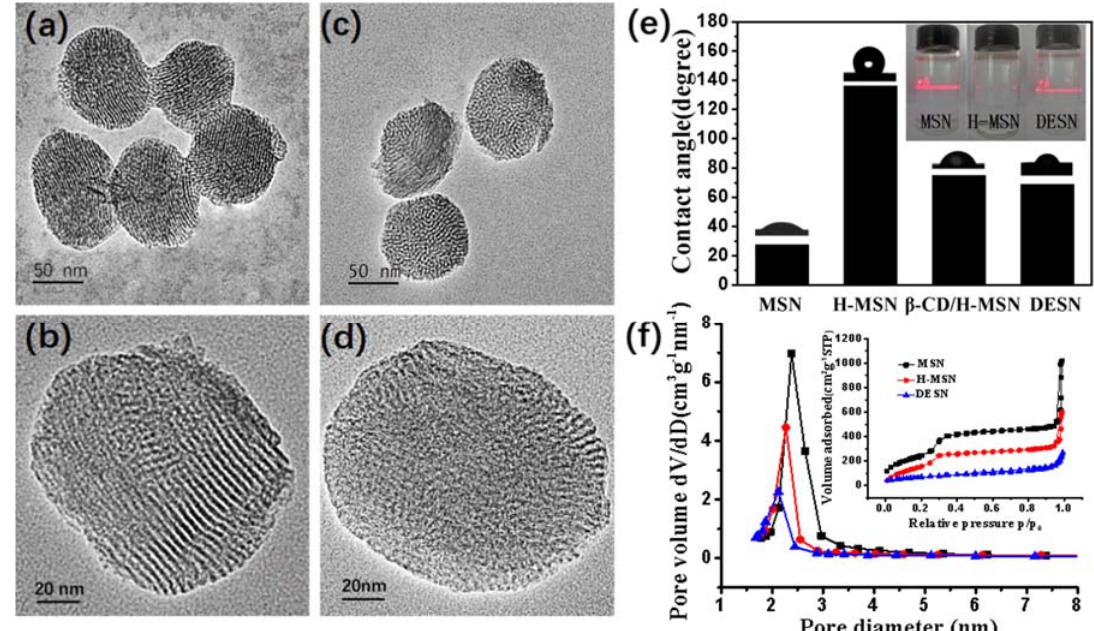
Figure 1. TEM images of MSN: ( a , b ) FA- β -CD/H-MSN; ( c , d ) Contact angle between nanoparticles (MSN, H-MSN, β -CD/H-MSN and DESN) and water in air, and the Tyndall effect of nanoparticles (MSN, H-MSN, and FA- β -CD/H-MSN) dispersed in water (the inset); ( e ) The pore size distribution curve and N 2 sorption isotherms (the inset) of MSN, H-MSN, and DESN and ( f ) The N 2 adsorption-desorption measurement was adopted to expose the effect of the β -CD coating and PTX storage on the porosity of MSN.